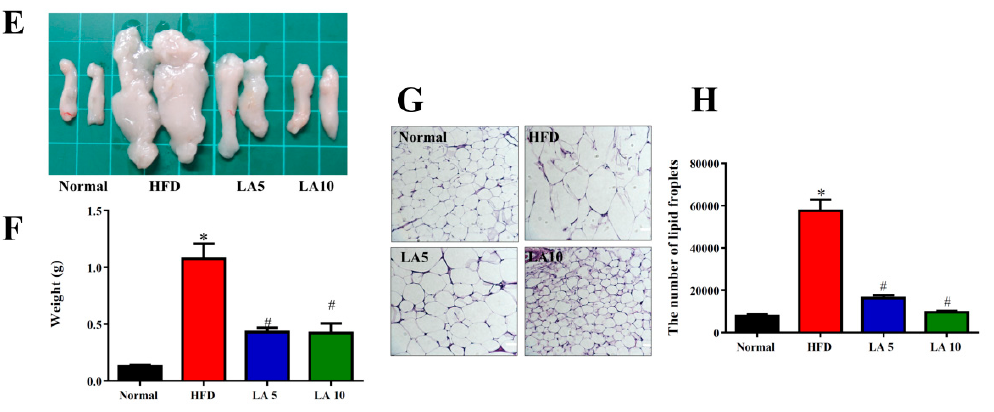
Figure 2. Licochalcone A (LA) reduced the epididymal and inguinal adipose tissue weights in HFD-induced obese mice. ( A ) The appearance and ( B ) weight of epididymal adipose tissue. ( C ) HE staining of epididymal adipose tissue (200 × magnification). ( D ) The adipocyte size in epididymal adipose tissue. ( E ) The appearance and ( F ) weight of inguinal adipose tissue. ( G ) HE staining of inguinal adipose tissue (200 × magnification). ( H ) The adipocyte size in inguinal adipose tissue. Data are presented as the mean ± SEM; n = 12. * p < 0.05, ** p < 0.01 compared with mice with HFD-induced obesity.